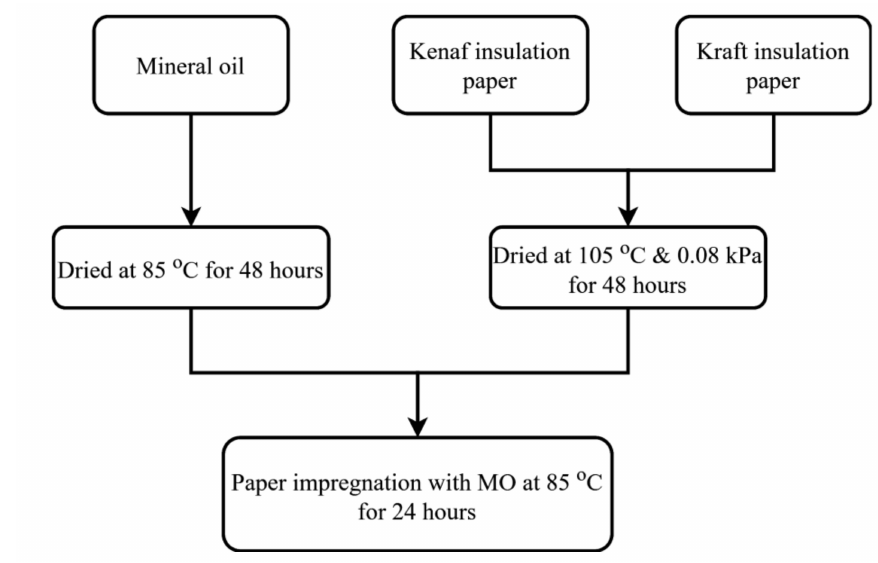
Figure 8. Pre-processing of oil and paper.